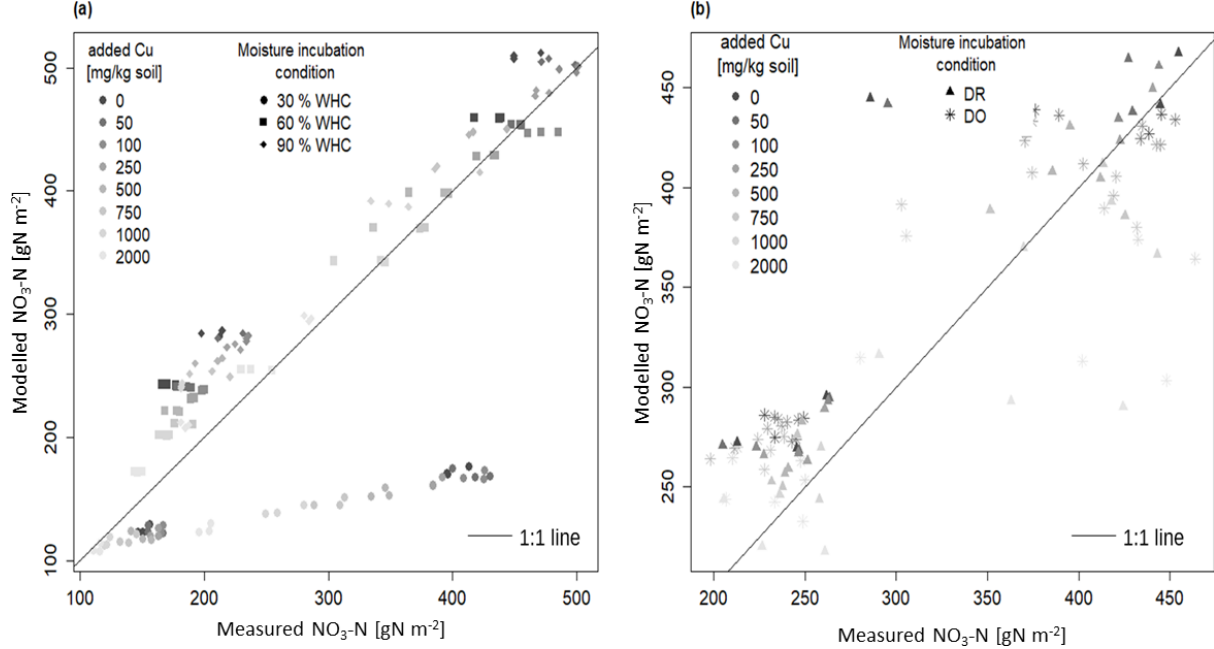
Figure 3. Comparison between modelled and measured soil nitrate concentration incubated in different moisture levels with 1 : 1 line: (a) the three initial incubations under constant moisture and (b) the two initial incubations under variable moisture Dry-Rewet (DR) and Dry-Only (DO) treatments. For 30% WHC, model = 1.84 · measure and R 2 = 0.93; for 60% WHC model = 0.93 · measure. R 2 = 0.99; for 90% WHC model = 0.90 · measure. R 2 = 0.99; for Dry-Rewet (DR) model = 0.96 · measure. R 2 = 0.98; for Dry-Only (DO) model = 0.95 · measure. R 2 =